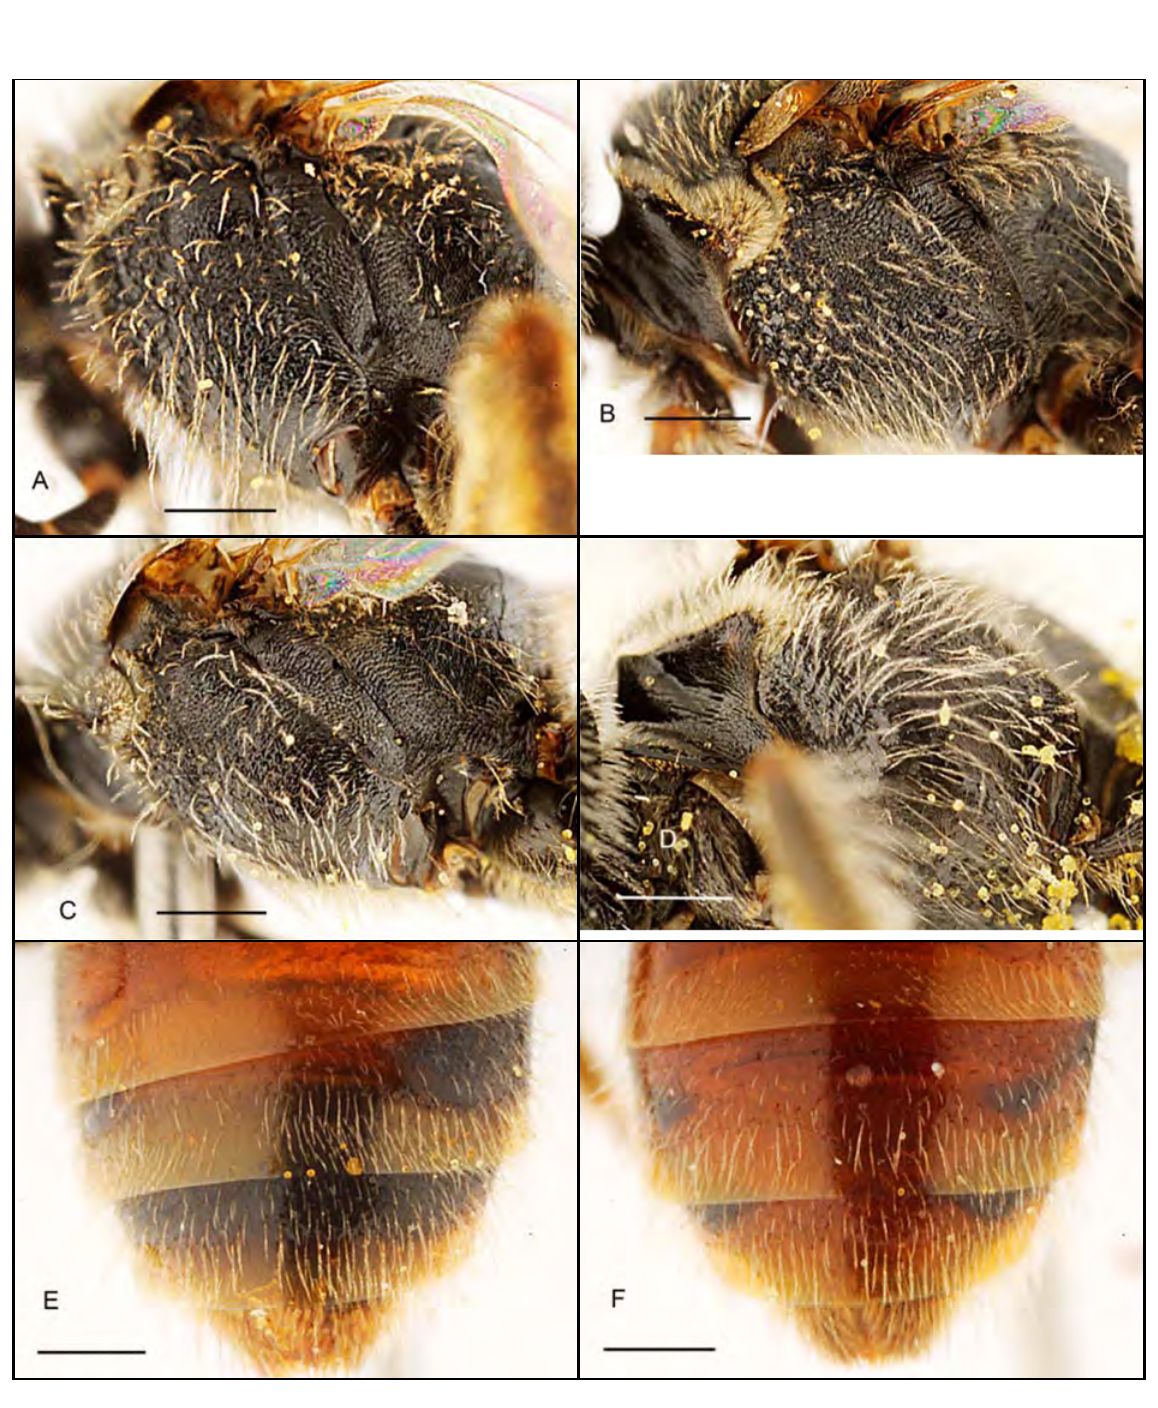
Fig. 16. A-D. Lateral view of mesosoma. E-F. Last terga. ♀♀. — A . Lasioglossum ( Capalictus ) mosselinum (Cockerell, 1945) . — B . Lasioglossum ( Capalictus ) timmermanni sp. nov. — C . Lasioglossum ( Capalictus ) hantamense sp. nov. — D . Lasioglossum ( Capalictus ) tigrinum sp. nov. — E . Lasioglossum ( Capalictus ) mosselinum (Cockerell, 1945) . — F . Lasioglossum ( Capalictus ) timmermanni sp. nov. Scale line = 0,5